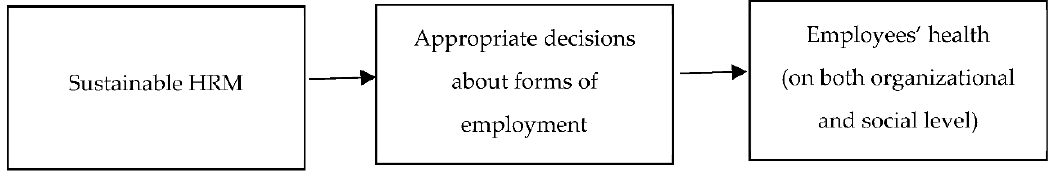
Figure 1. The choice of forms of employment as a part of sustainable human resource management